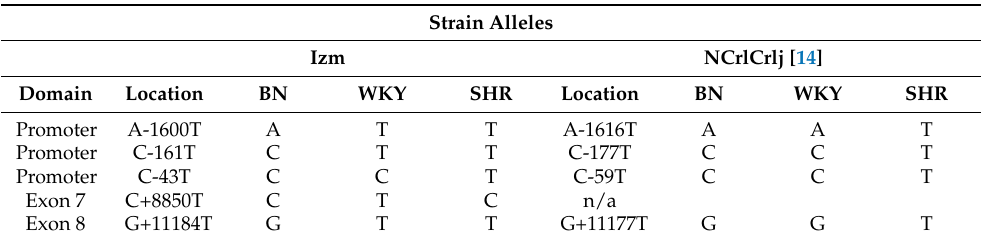
Table 1. Single nucleotide polymorphisms (SNPs) in the Chga gene between WKY rats (WKY/Izm) and SHRs (SHR/Izm) using Brown Norway rats as a reference